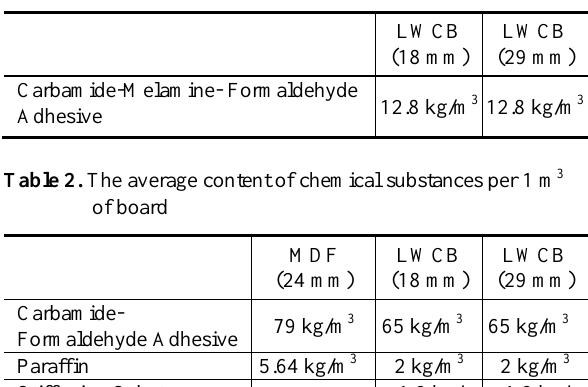
Table 1. The average amount of chemical substances per 1 m 3 of laminate